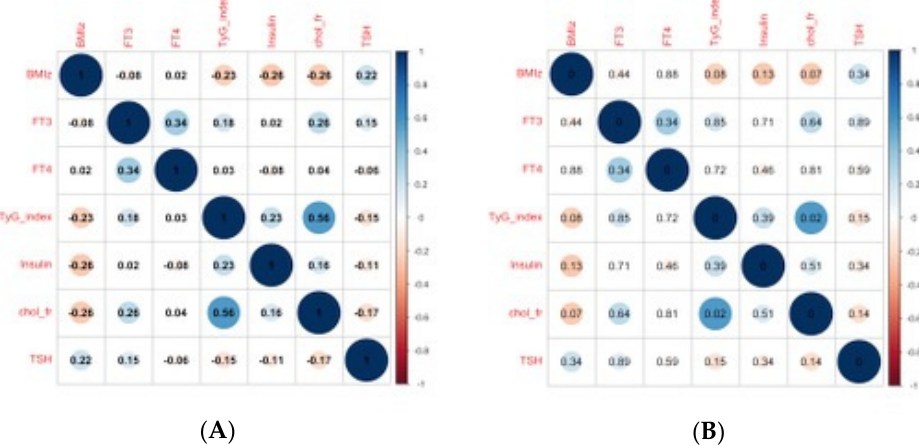
Figure A1. Violin plots showing the distribution of the numeric variables separated for the classes of the group studied. The graphs were distributed in three different panels ( A – C ) due to space con- straints: Control children (Ctrl), Children with neuromotor impairment (Disb), Children with neu- romotor impairment and Metabolic derangement (Disb + MetDer).